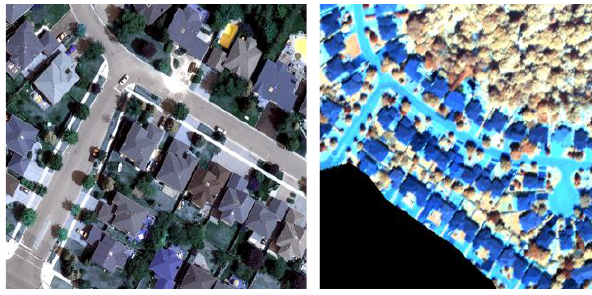
Figure 2. The true colour composite VHR imagery (left) and false colour composite of the CASI imagery covering Site 2 (43.777503°N,